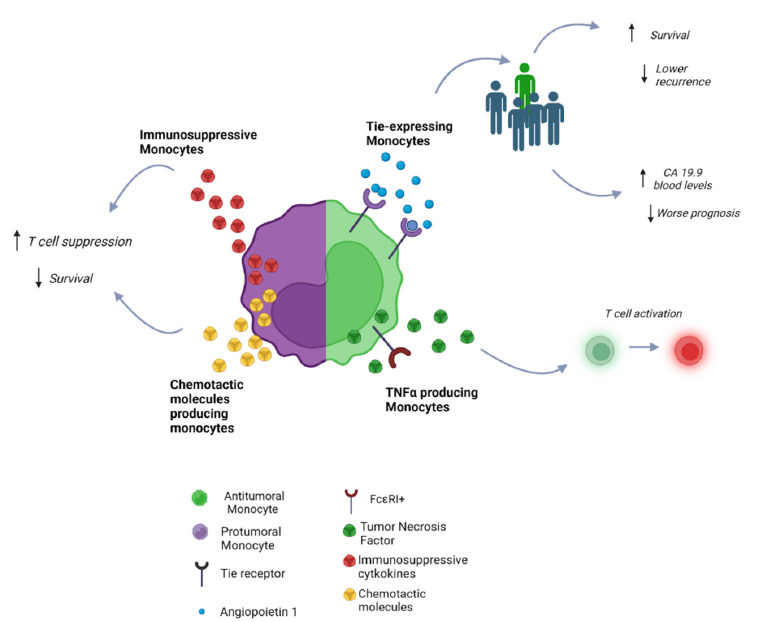
Figure 2. Monocyte subclasses in CCA. Tie-expressing monocytes and TNF- α -producing monocytes are identified as subgroups of “antitumoral monocytes” (right, green) in CCA, whereas immuno- suppressive monocytes and chemotactic-molecule-producing monocytes are classified as subsets of “protumoral monocytes” (left, purple).